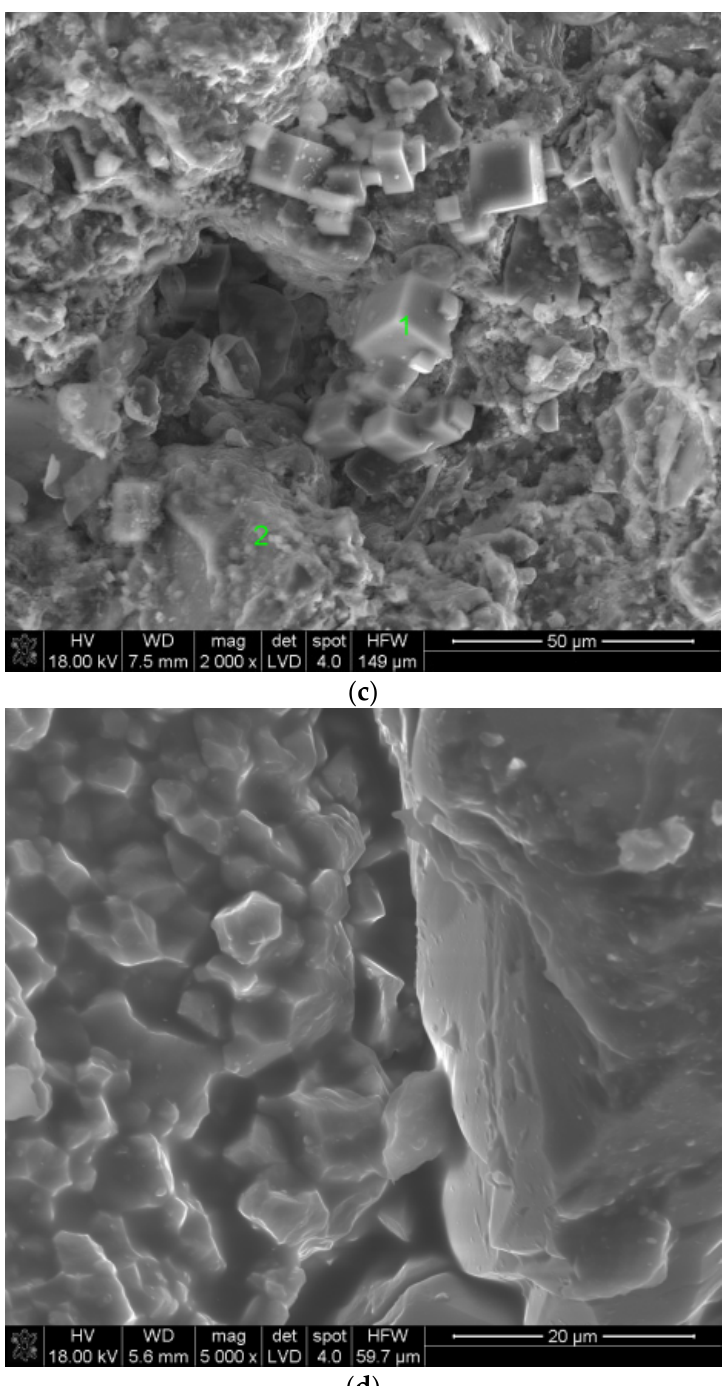
Figure 7. SEM images of: ( a ) limestone infiltrated with Ormosil IV; ( b ) limestone infiltrated with Sarsil H1 4/2; ( c ) old brick infiltrated with Sarsil H 14/2; ( d ) sandstone infiltrated with Ormocer V.